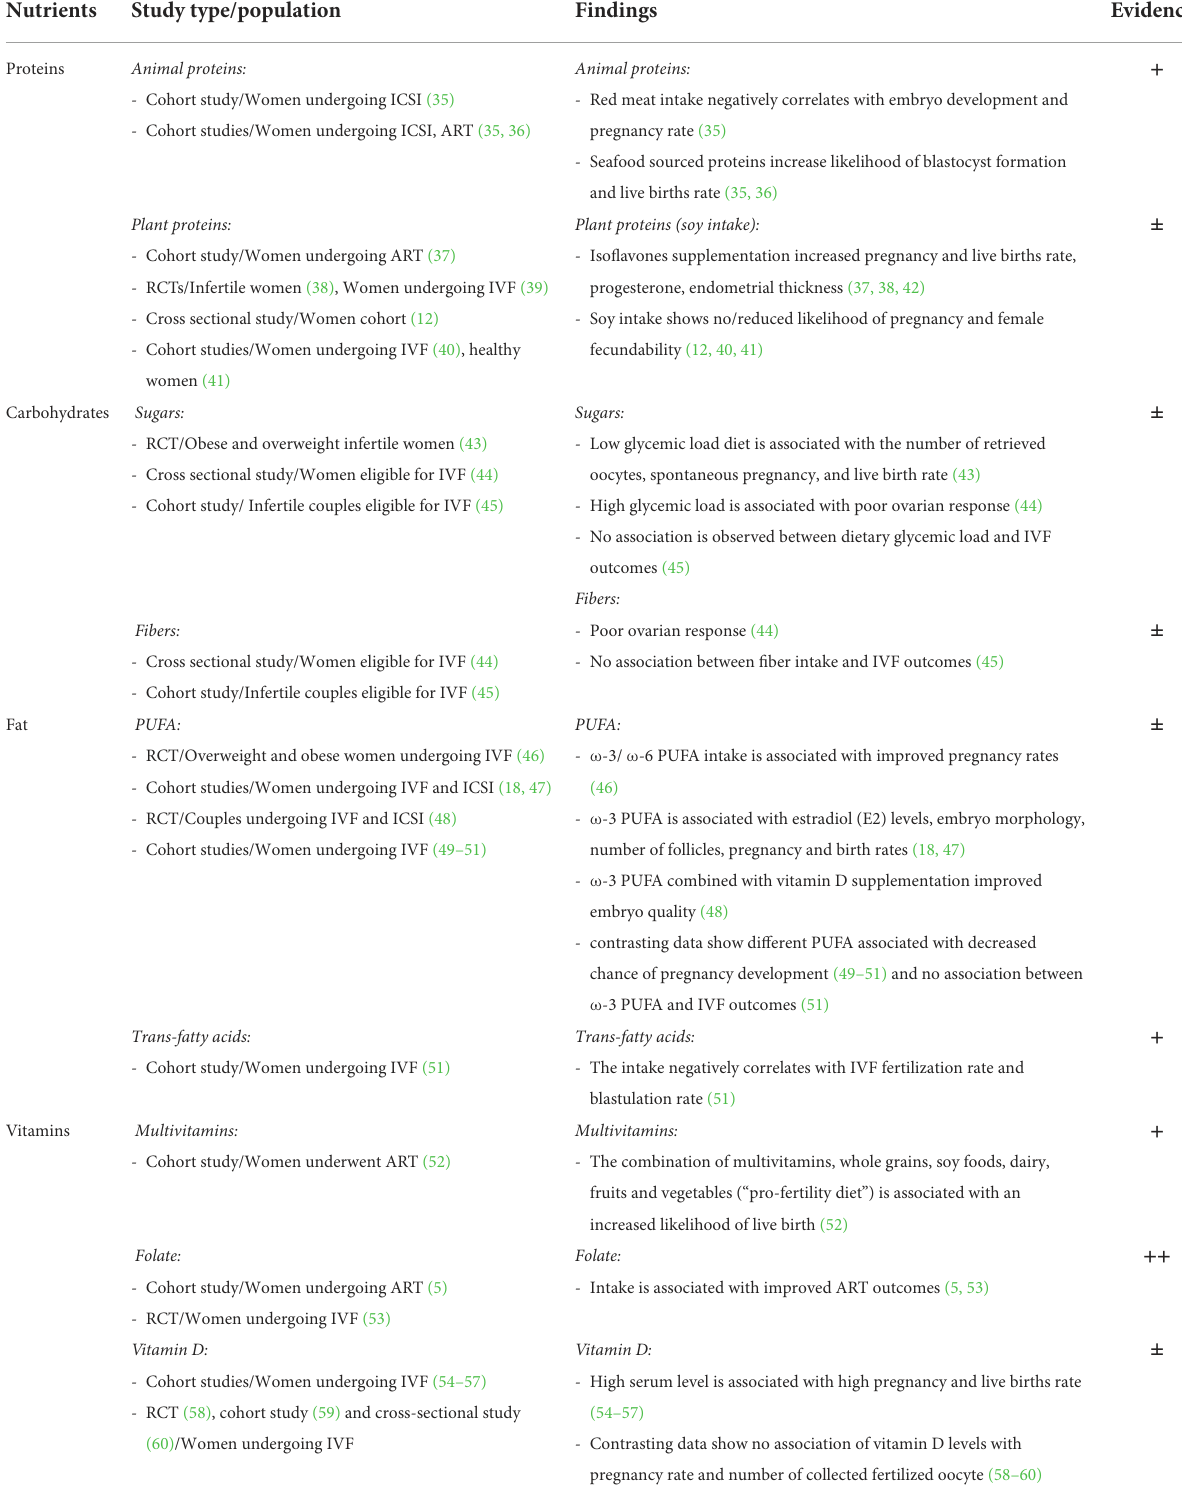
TABLE 2 The effect of several nutritional factors and dietary patterns on ART outcomes. Assisted reproductive technologies Findings Evidence